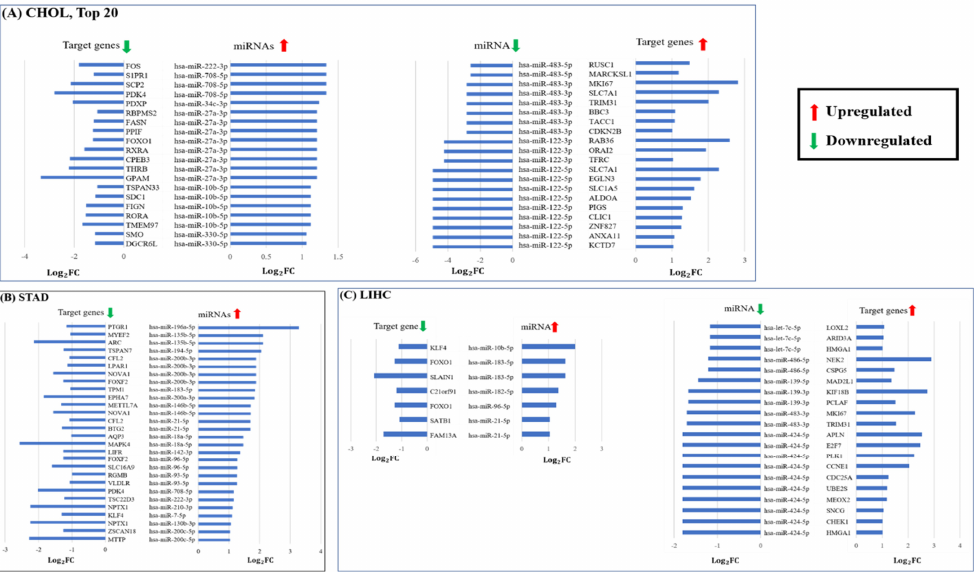
Figure A2. The mintRULS predicted interacting pairs in the upper quartile (>75th percentile) which have a negative correlation between miRNA and target gene expression in different gastrointestinal (GI) cancer types ( A ) cholangiocarcinoma (CHOL), ( B ) stomach adenocarcinoma (STAD), and ( C ) liver hepatocellular carcinoma (LIHC). The only pairs with classification “Experimental evidence” or “High prediction” in IPA analysis were considered . All the observations are significant with adj p value < 0.05. FC: Fold change, miRNA: microRNA. For upregulation, Log 2 FC > 1, and for downregulation Log 2 FC < − 1 criteria were set.